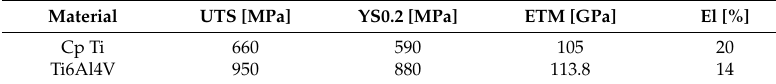
Table 3. Mechanical properties of CPTi and Ti6Al4V.